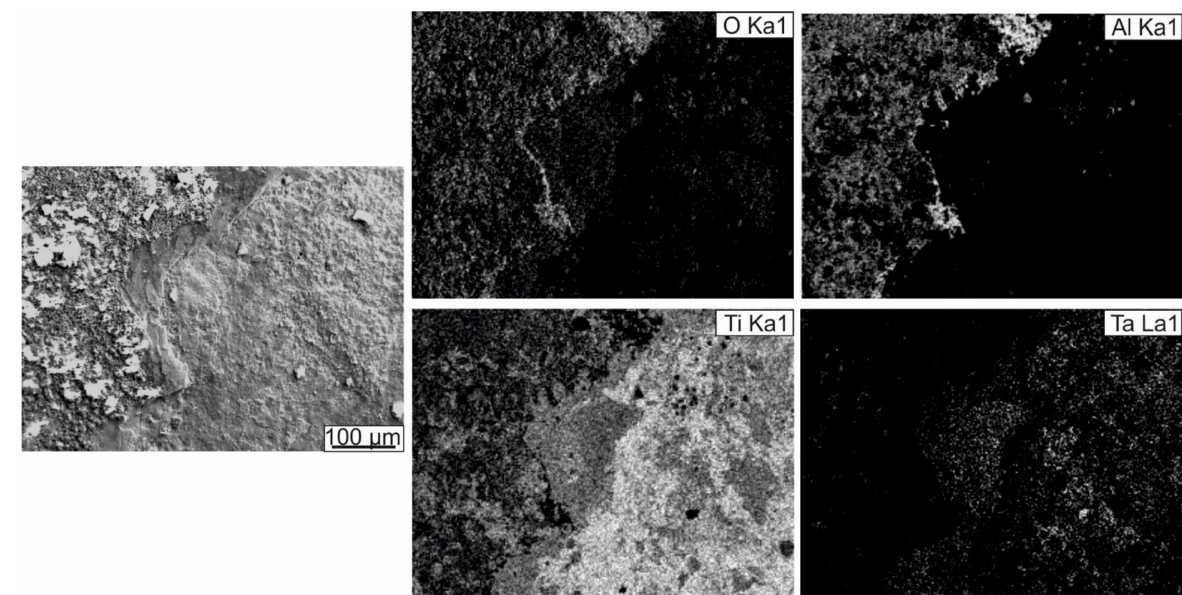
Figure 12. Oxide scale formed after oxidation at 800 ◦ C for 200 h on a surface of Ti-41Al-7Ta alloy. Results of EDX